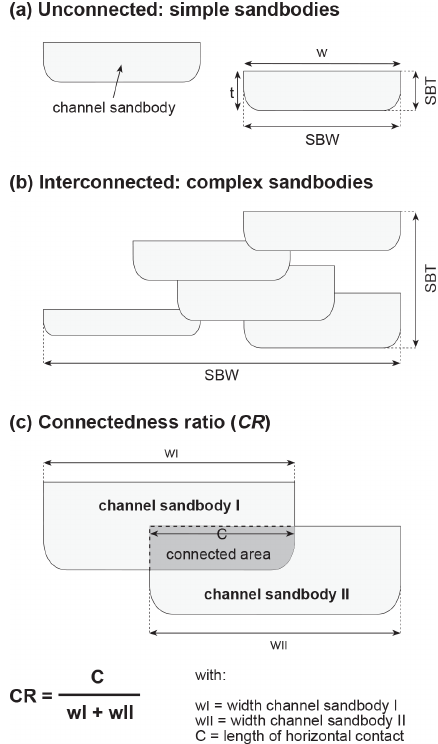
Figure 4. Definition diagram showing geometric properties of flu- vial channel-belt sand bodies (after Gouw, 2008, based on Mackey and Bridge, 1995). A channel-belt sand body may be composed of either a single channel-belt sand body (simple channel-belt sand body) or multiple interconnected channel-belt sand bodies (complex channel-belt sand body). The dimensions (SBW, SBT) of a simple channel-belt sand body are equal to the dimensions of the channel- belt sand body ( w , t ) that constitutes the simple sand body (a) . In cases of complex channel-belt sand bodies, SBW and SBT may be significantly larger than the dimensions of the individual channel- belt sand bodies that are part of the complex sand body (b) . Calcula- tion of the connectedness ratio (CR) is schematically shown in (c)